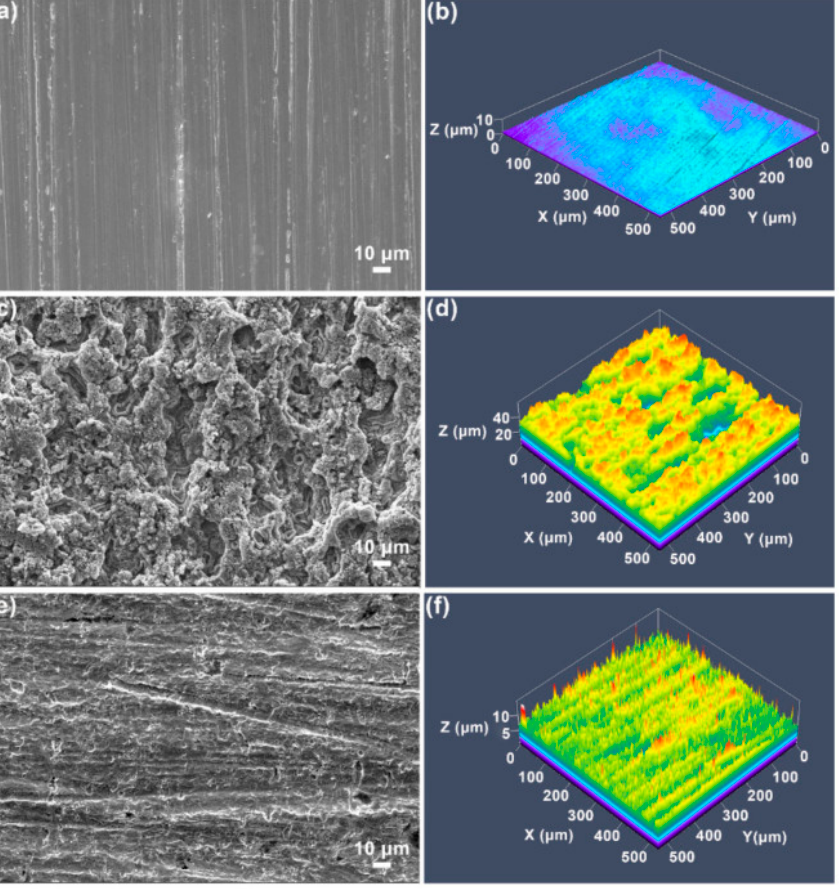
Figure 18. LSCM and SEM scans of Q235 CS substrate following 60 h of subjection to 1 M HCl medium with the exclusion and inclusion of 400 ppm NCDs, ( a , b ) refined steel, ( c , d ) in blank media, ( e , f ) with the inclusion of 400 ppm NCDs. Reprinted with permission from Ref. [90]. MDPI (2021).